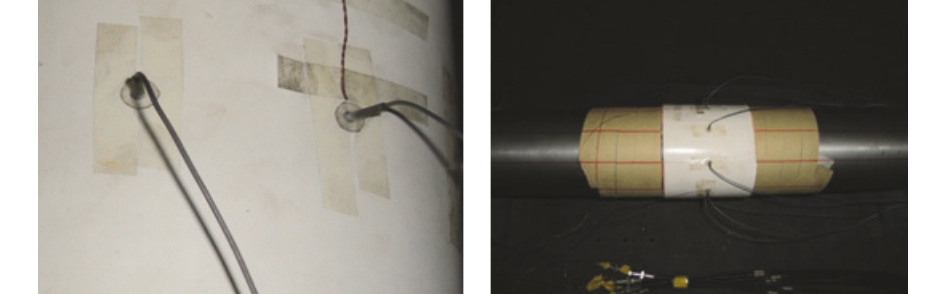
Figure 3: Photos of experiment.